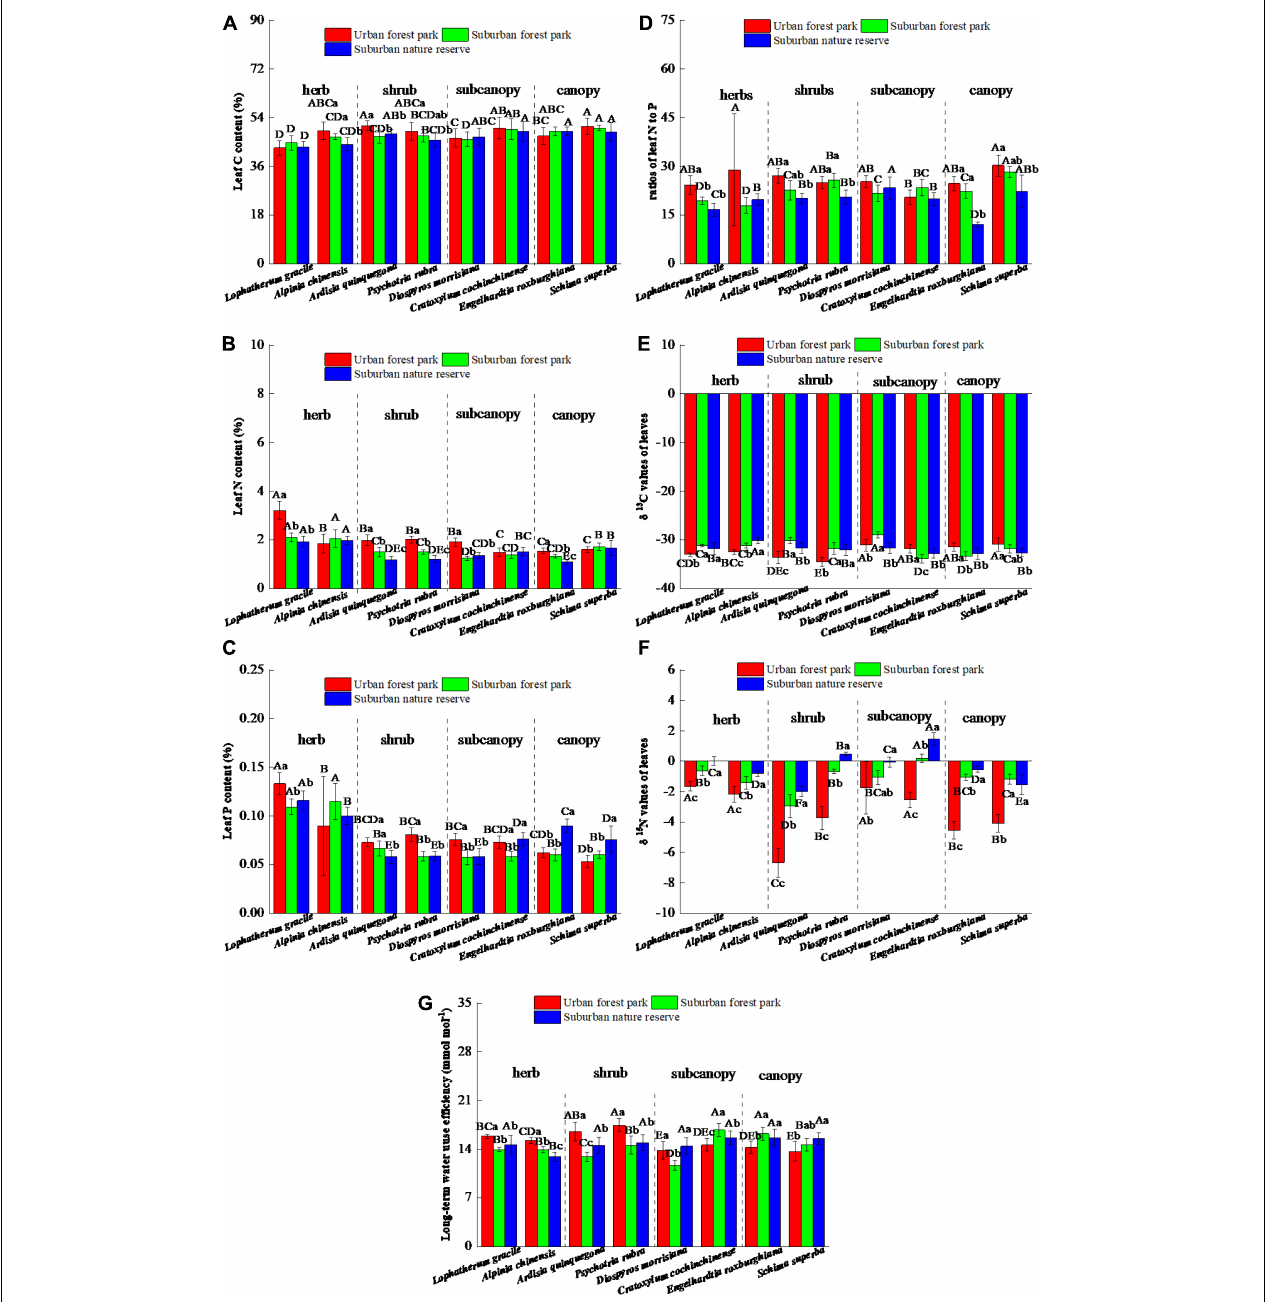
FIGURE 1 | Effects of growth environment on (A) C content, (B) N content, (C) P content, (D) ratios of N to P, (E) δ 13 C, (F) δ 15 N, and (G) long-term water use efficiency of leaves of eight plant species. The lowercase letters reveal the significant differences ( P < 0.05 ) of the same species among different growth environments, and the capital letters reveal the significant differences ( P < 0.05 ) of different species in the same growth